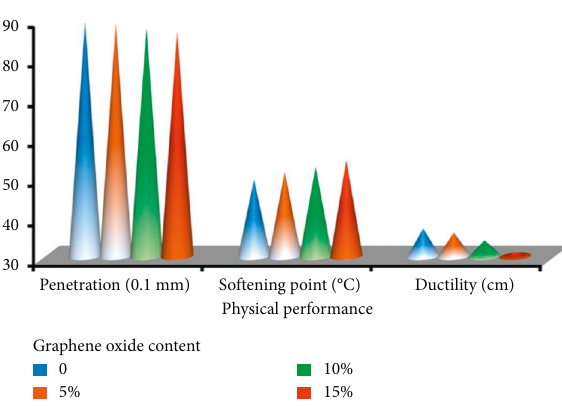
Figure 6: Physical performances of GO-modified